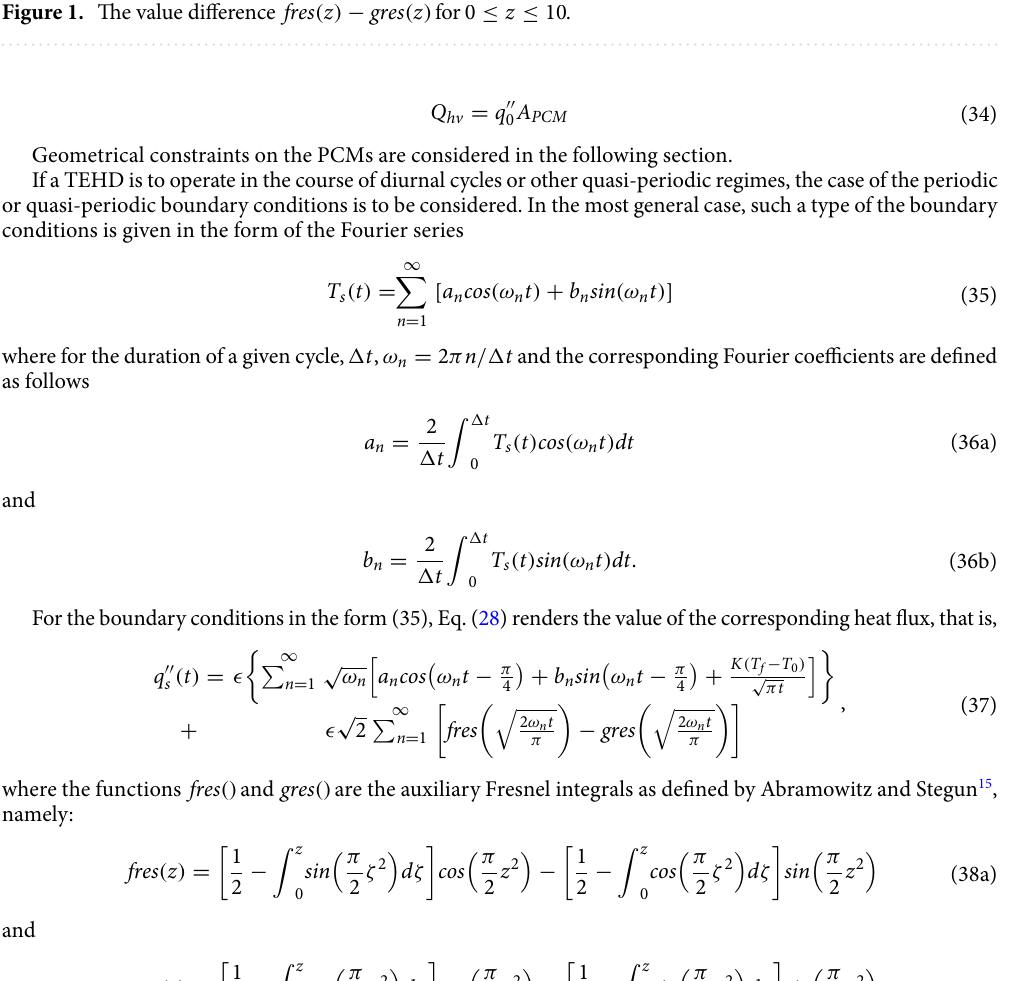
Figure 1. The value difference fres ( z )